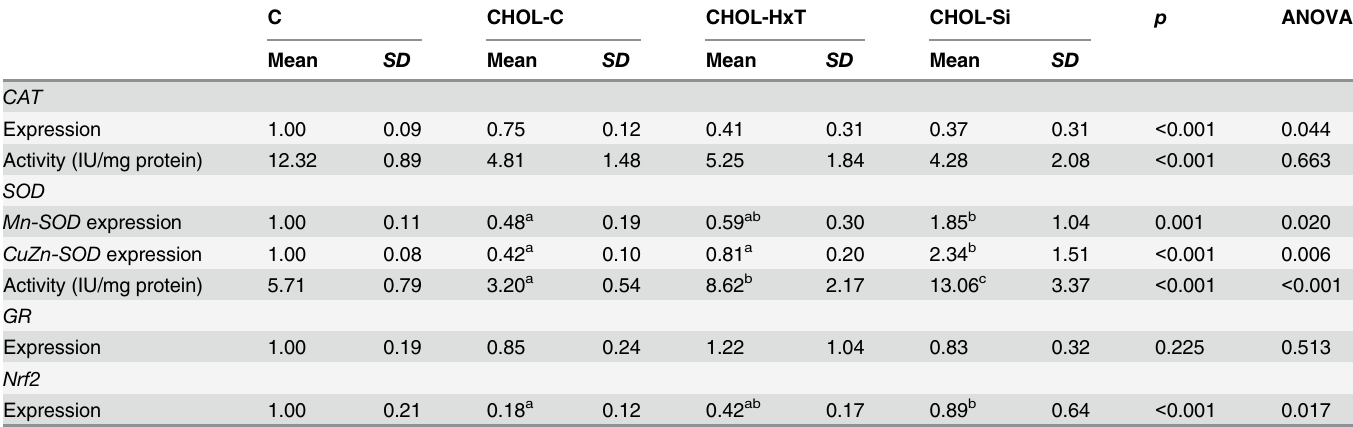
Table 4. Liver enzymes expressions and activities of aged rats fed cholesterol-enriched high saturated/high cholesterol diets containing hydroxy- tyrosol- or silicon-restructured